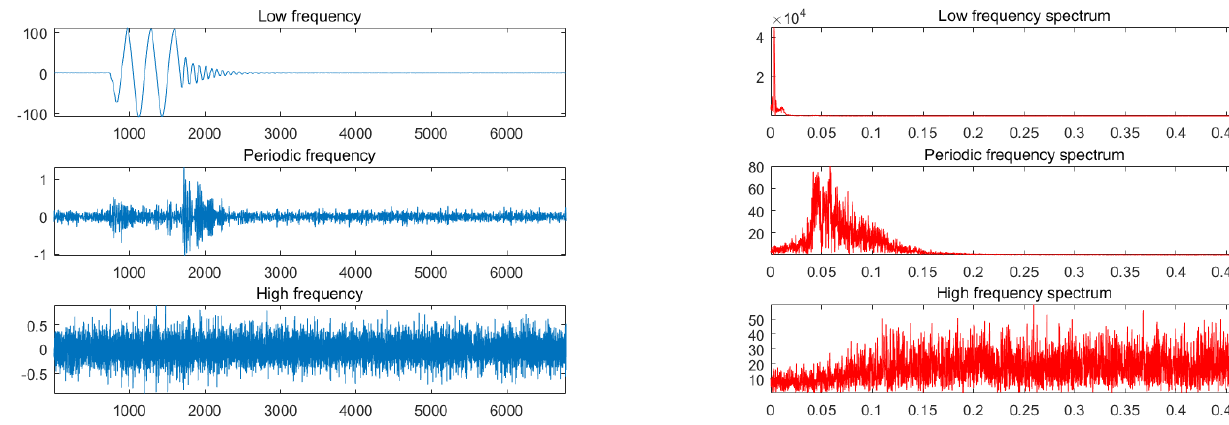
Figure 8. Reconstructed signal and spectrum of Line 2.